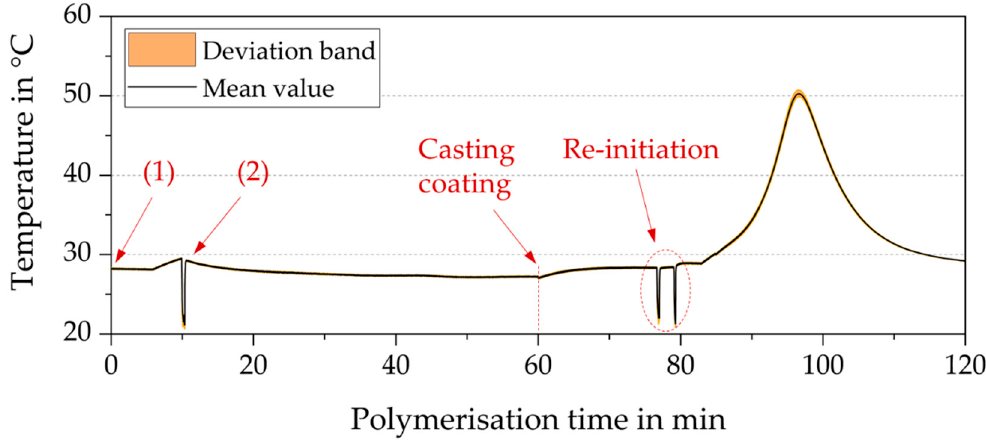
Figure 6. The temperature record of a 1 g PBM sample subjected to the controlled radical polymerization (CRP) protocol.